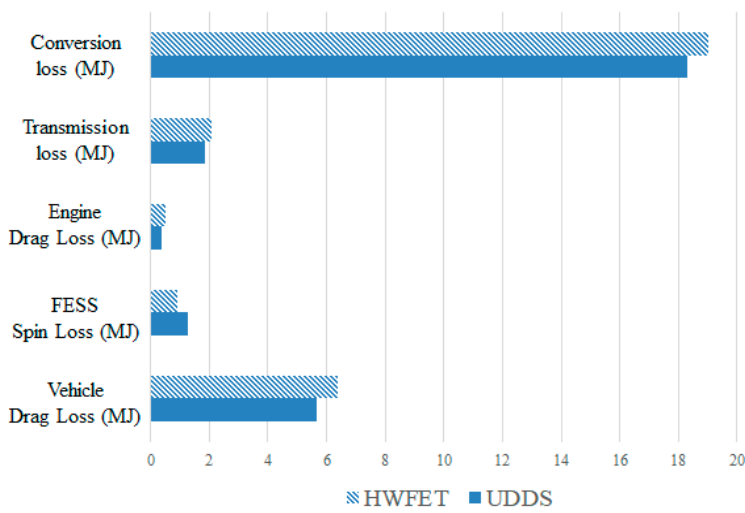
Figure 23. The loss analysis of fuel energy in driving cycle simulations.